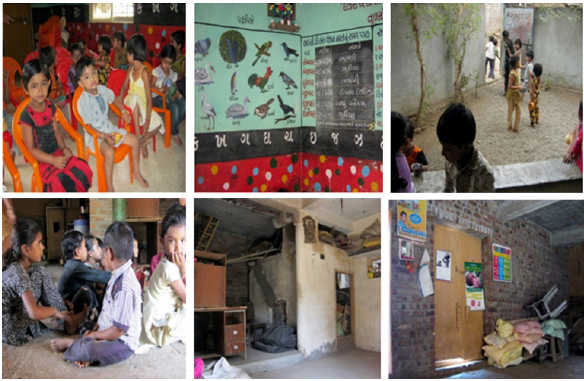
Fig 2. AWCs for ‘Upper’ Caste (Top Row) and Dalit (Bottom Row) Children